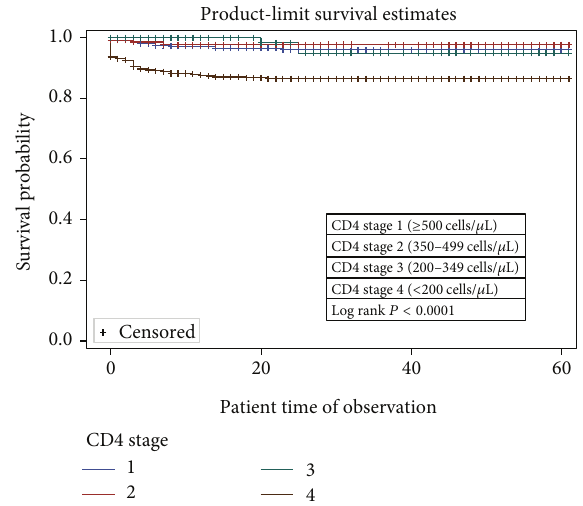
Figure 2: Survival curves based on age group among patients in NCH.